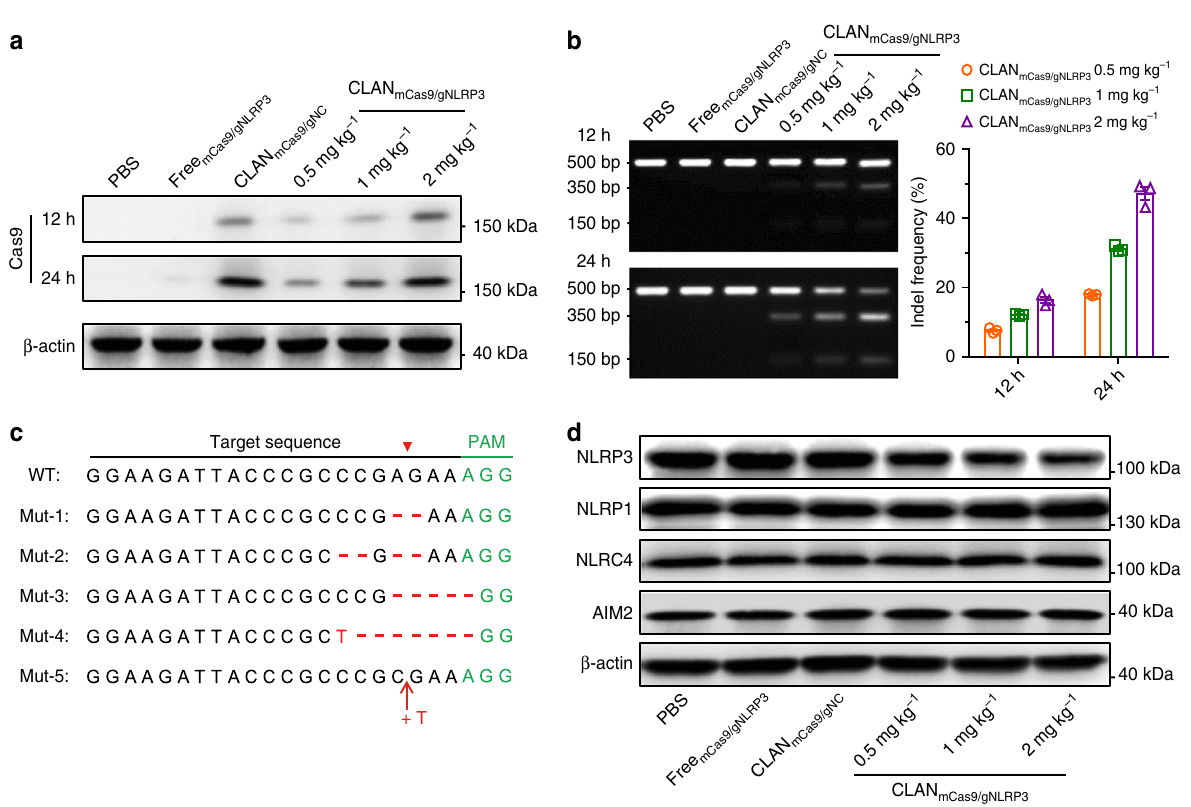
Fig. 4 Detection of Cas9 expression and NLRP3 knockout ef fi ciency in macrophages of mice injected with CLAN mCas9/gNLRP3 . a , b Immunoblot analysis of Cas9 protein expression ( a ) or the T7E1 assay of indels introduced into the NLRP3 locus ( b ) in peritoneal macrophages of mice injected with CLAN mCas9/ n = 5 per group. c Representative sequences of indels in the NLRP3 locus, see also Supplementary Fig. 10. d Immunoblot gNLRP3 at 12 or 24 h post-injection. analysis of NLRP3 and other in fl ammasome protein expression in peritoneal macrophages of mice injected with CLAN mCas9/gNLRP3 at 72 h post-injection. n = 5 per group. The data are representative of two independent experiments ( a , d ) or are shown as the means± SEM of n = 3 ( b